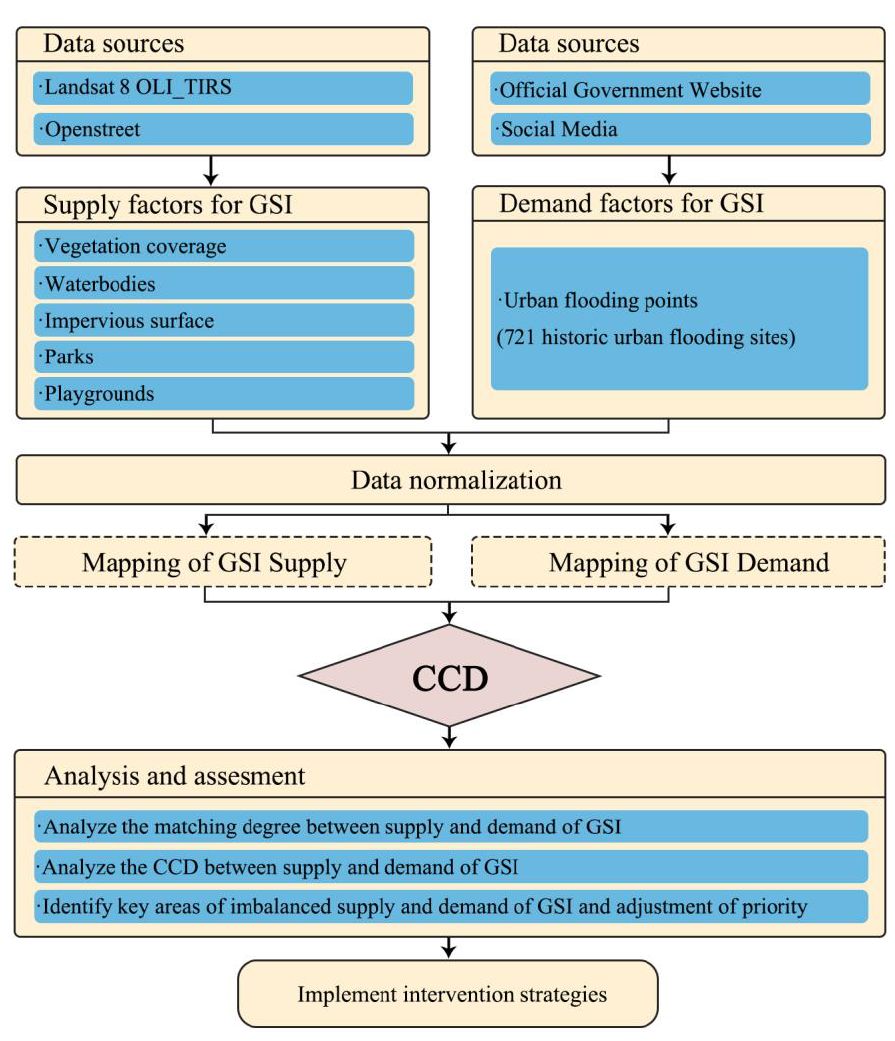
Figure 1. Study framework. Note: CCD—Coupling Coordination Degree model; GSI—Green Stormwater Infrastructure.